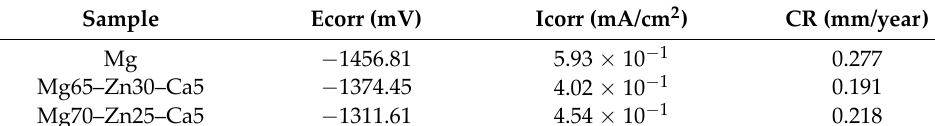
Table 4. Ecorr, Icorr, and corrosion rate of Mg, Mg65–Zn30–Ca5, and Mg70–Zn25–Ca5.